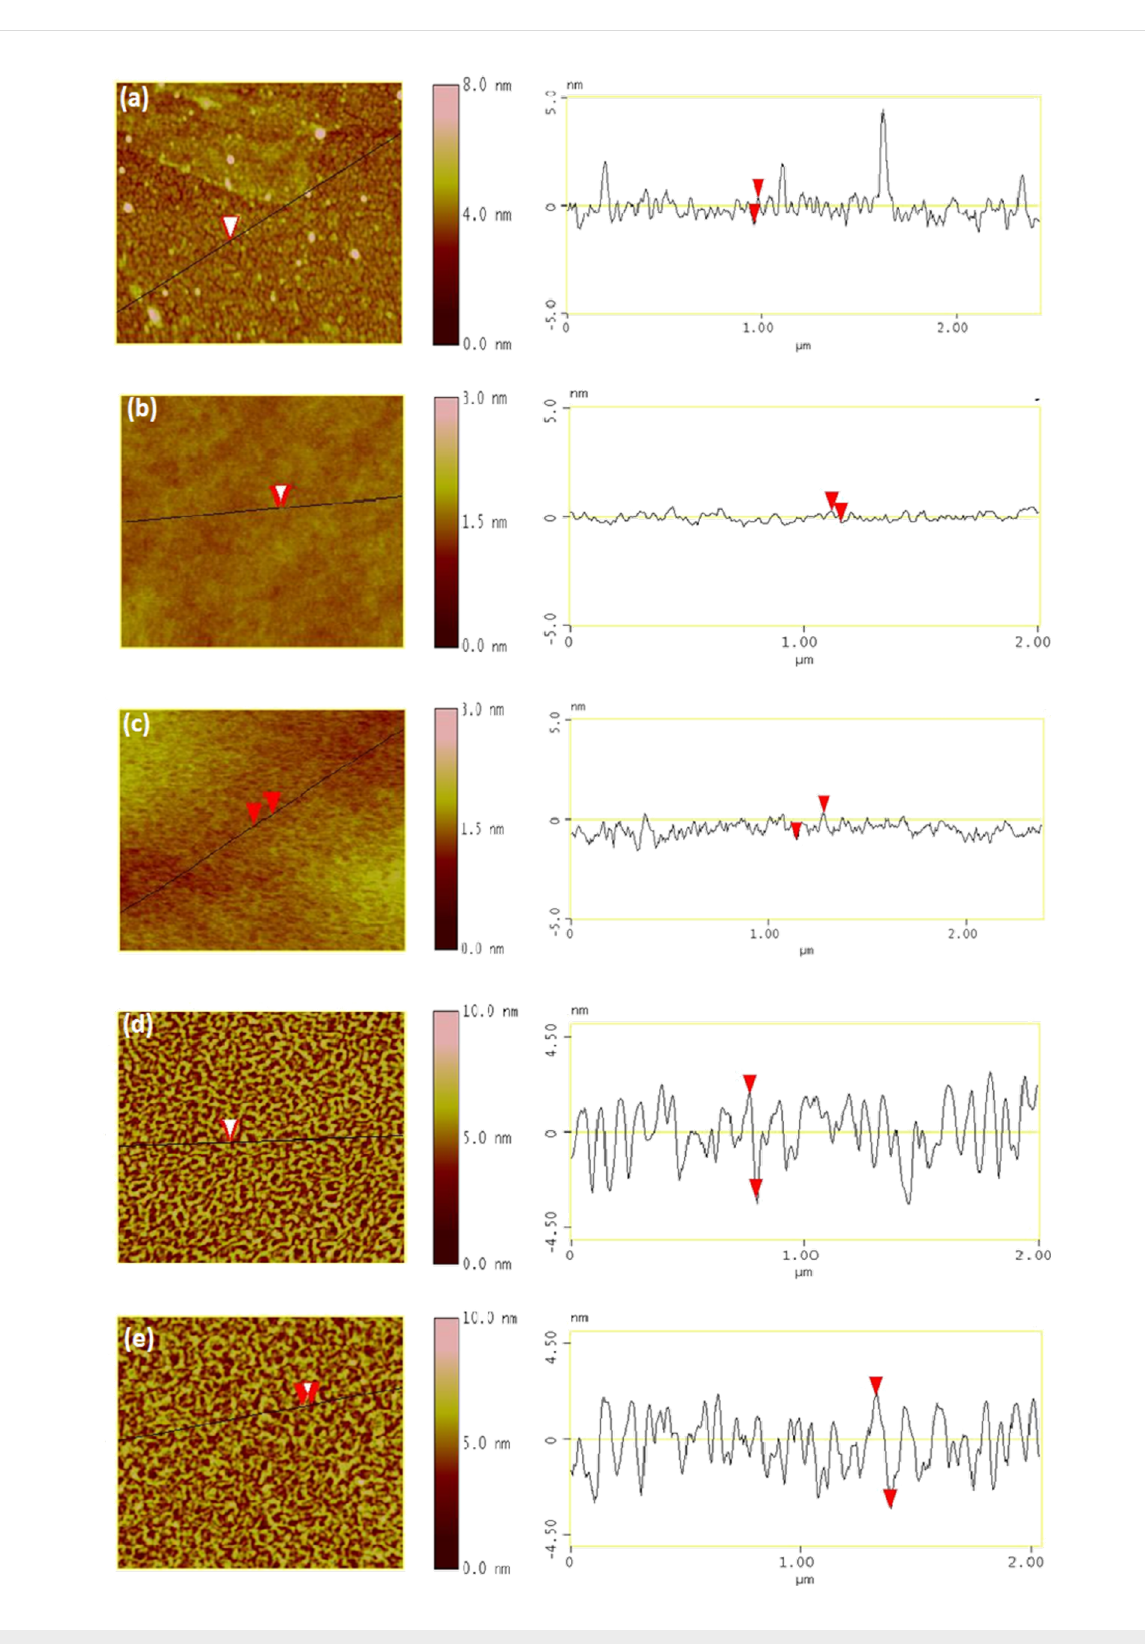
Figure 2: AFM images: a) pristine film, b–e) films irradiated with 50 keV, 140 keV, 350 keV and 600 keV,